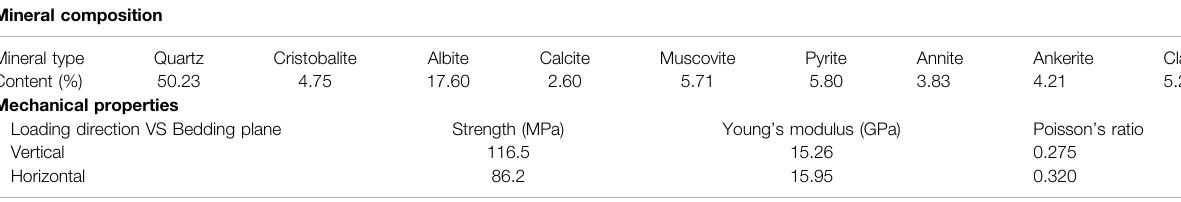
TABLE 1 | Mineral composition and mechanical properties of sampled marine shale.